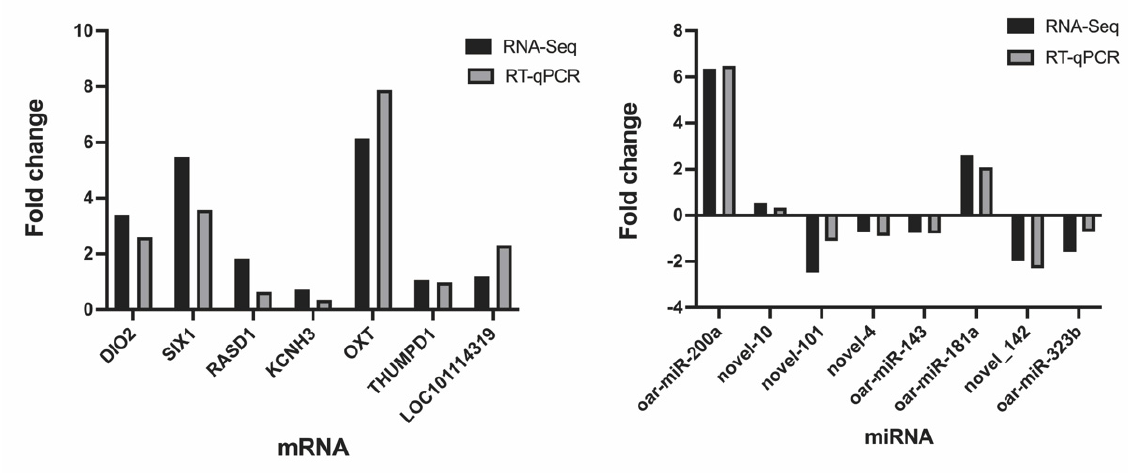
Figure 8. qPCR validation of mRNAs and miRNAs identified by RNA − seq.